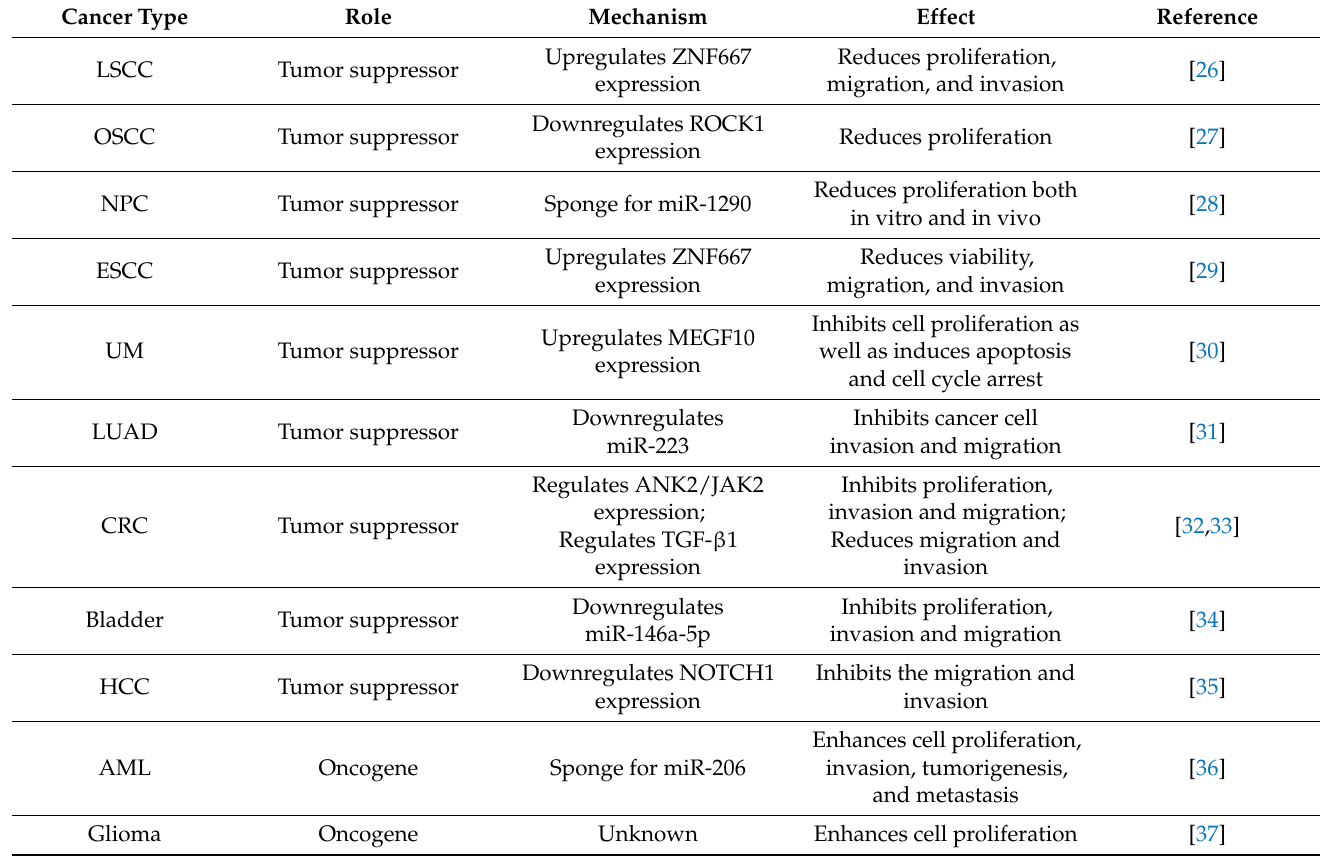
Table 1. Pathological role of MORT (ZNF667-AS1) in